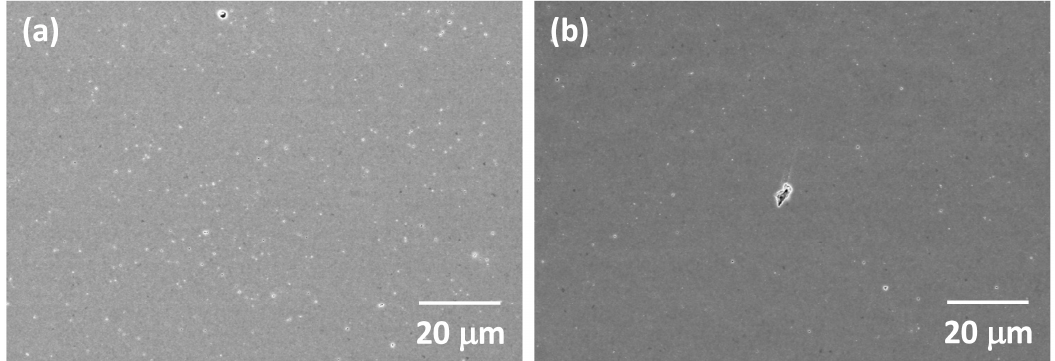
Figure 18. SEM micrographs of ( a ) a two-step sintered sample (T1 = 1400 °C, T2 = 1350 °C, t2 = 5 h) and ( b ) a conventionally sintered sample, both prepared using ball milled powder. Table 3. Area porosity of conventionally and two-step sintered samples shown in Figures 17 and 18.